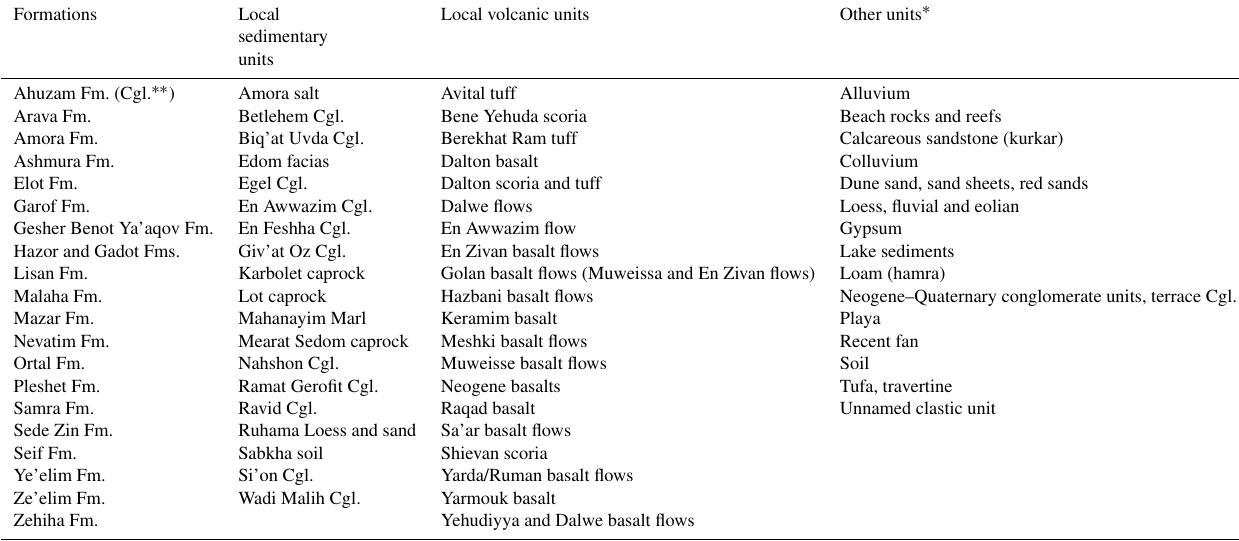
Table A2. List of geological formations and units used for the Quaternary fault map of Israel. Formations